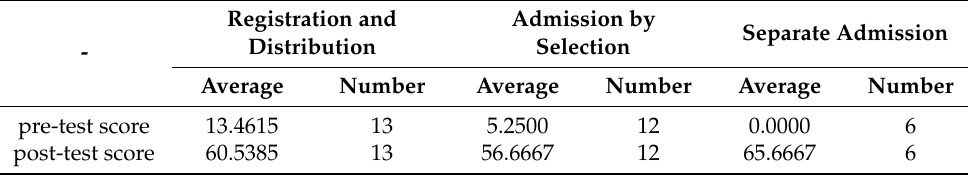
Table 4. Pre-test and post-test scores of students enrolled through different channels in 2019.